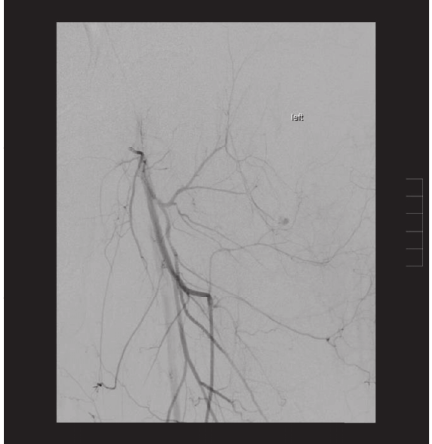
Figure 3: Left lower extremity angiogram demonstrates an area of contrast extravasation arising from a peripheral deep femoral branch.